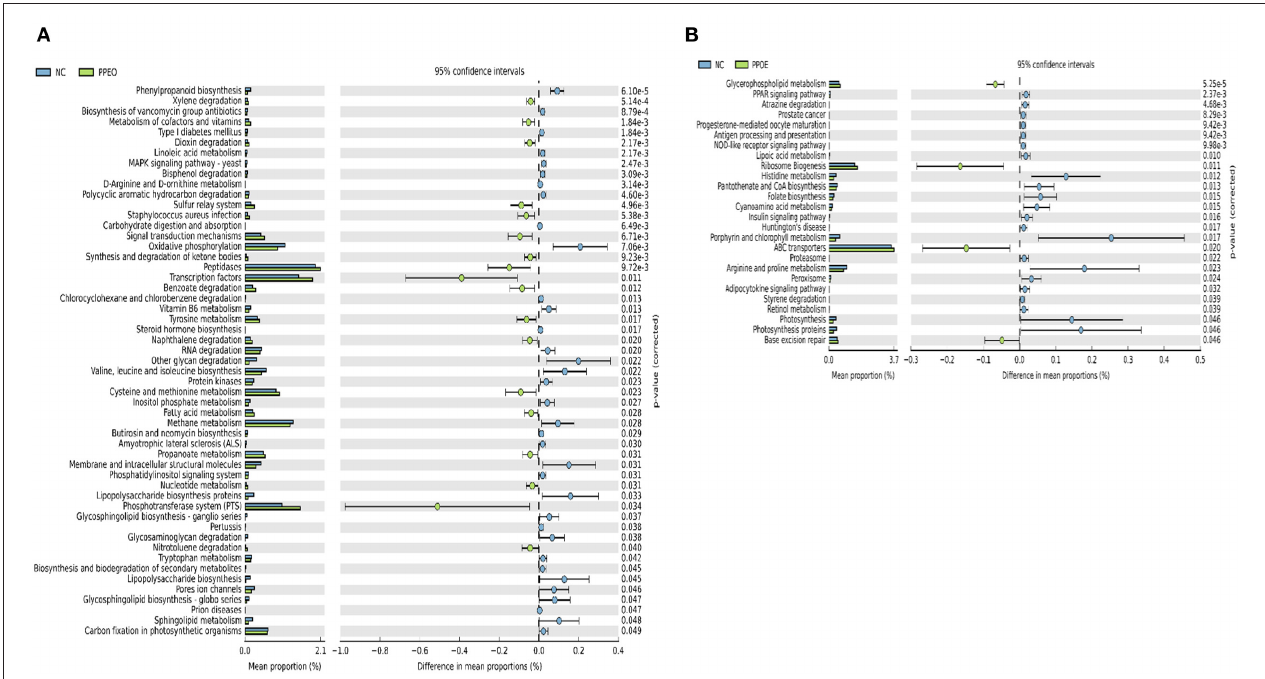
FIGURE 6 | Predicted functions of ileal mucosa microbiota in broiler chickens challenged with a subclinical naturally occurring necrotic enteritis at KEGG levels 3 ( n = 8/treatment). (A,B) Differentially regulated metabolic pathways in NC vs. PPEO group on d 8 and d 42, respectively. NC (negative control): corn-soybean meal basal diet; PPEO (probiotic/prebiotic/essential oil supplement): NC + 453 g/ton of a supplement containing B. licheniformis spores, mannan-oligosaccharides, β -glucans (1,3 and 1,6), capsaicin, and